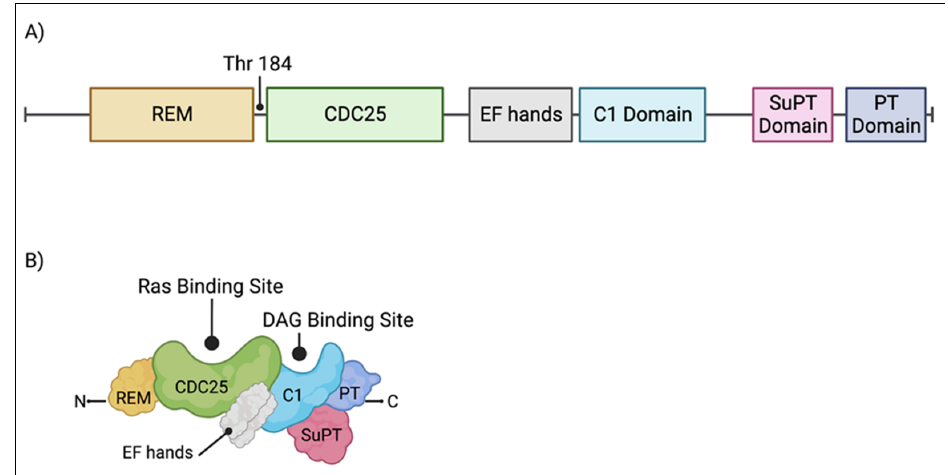
Figure 2. RasGRP1 domains. ( A ) Individual protein domains and the PKC-phosphorylation site, threonine 184, are diagramed and labelled. ( B ) An illustration of RasGRP1 protein domains. The Ras and DAG binding sites are labelled. Created with BioRender.com.